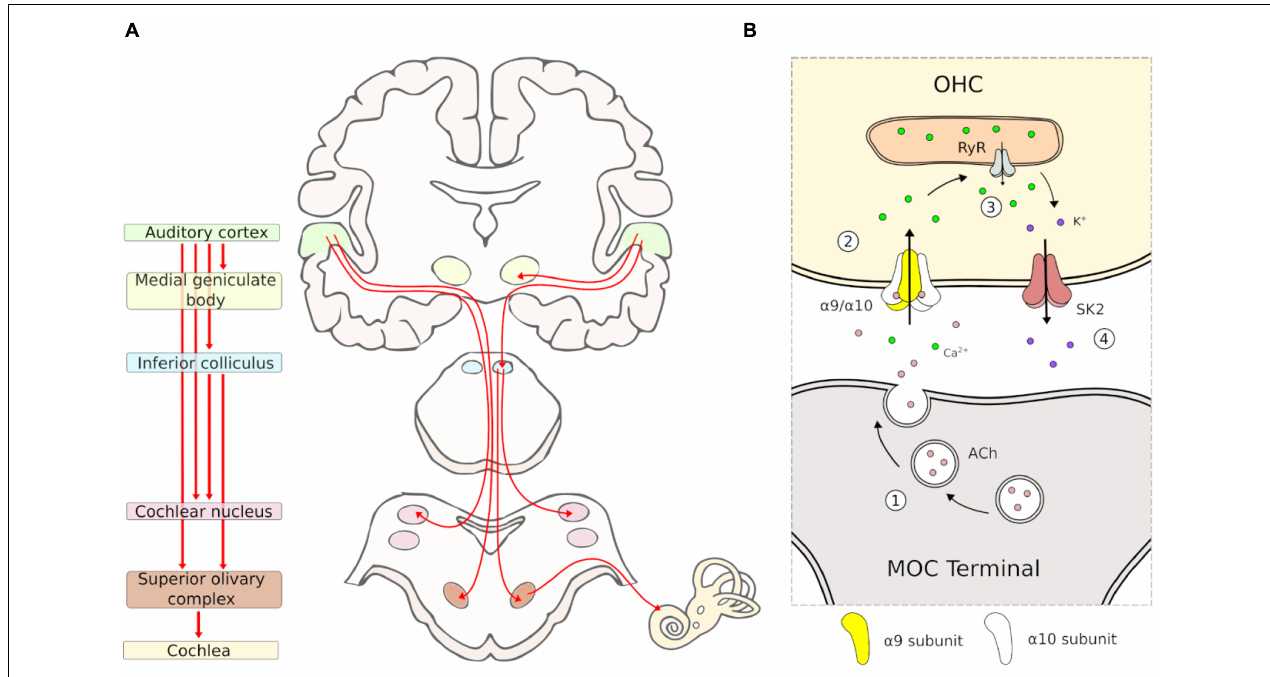
FIGURE 1 | Schematic representation of auditory efferent system pathway and MOC-OHC synapse. (A) Diagram of the auditory efferent system. Efferent pathways are depicted in red arrows. The auditory cortex, medial geniculate body, inferior colliculus, cochlear nucleus, superior olivary complex and cochlea are depicted with the same color in the left and right panel. (B) Diagram of the MOC-OHC synapse. Acetylcholine (ACh) is released from the MOC terminal (1) and binds the postsynaptic α 9/ α 10 receptor, which produces a Ca 2 + influx (2). Then, the calcium-induced calcium release by ryanodine receptor (RyR) in the synaptic cistern (3) activates SK2 channels with the subsequent K + efflux (4), producing a hyperpolarization of the OHC.